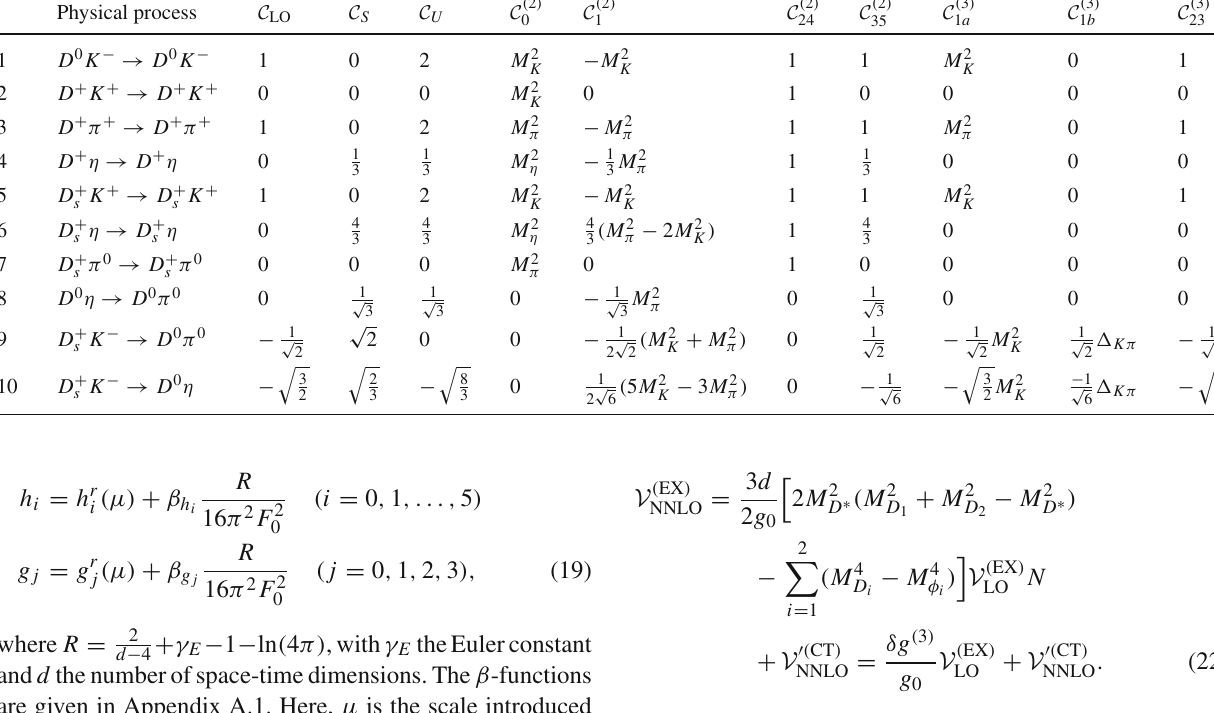
Table 1 The coefficients in the tree-level amplitudes for the ten relevant physical processes, with (cid:5) K π = M 2 Physical process C